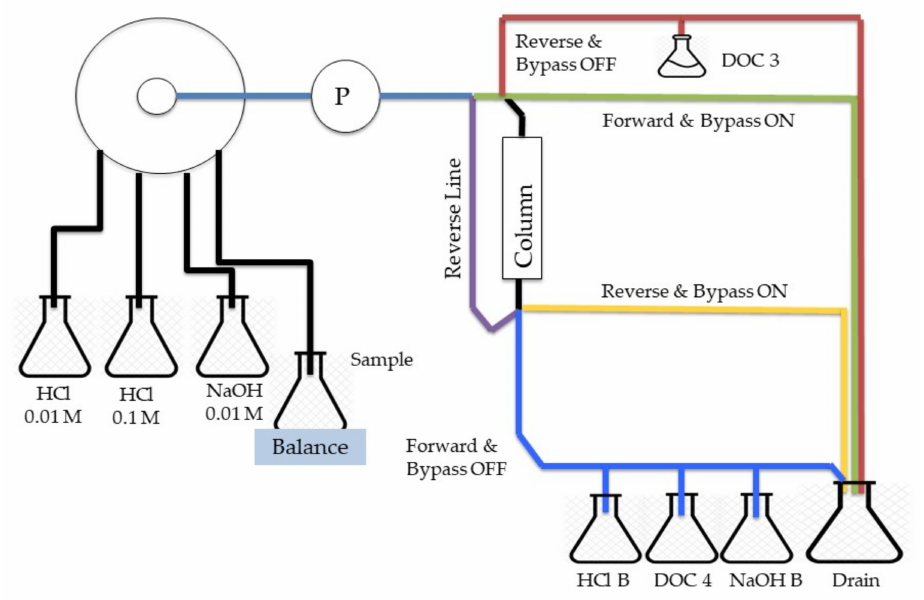
Figure 8. Schematic of Auto Fractionation